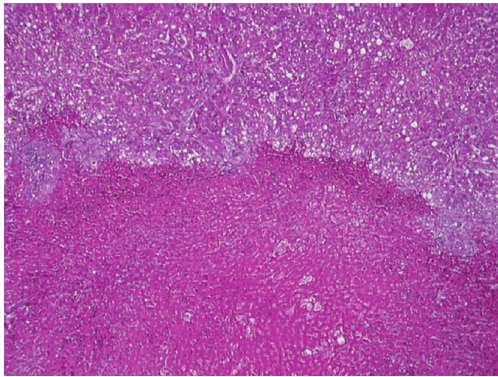
Figure 2: Native liver (40x, H&E section): at low power, one may appreciate the interface between viable and necrotic hepatic tissue.